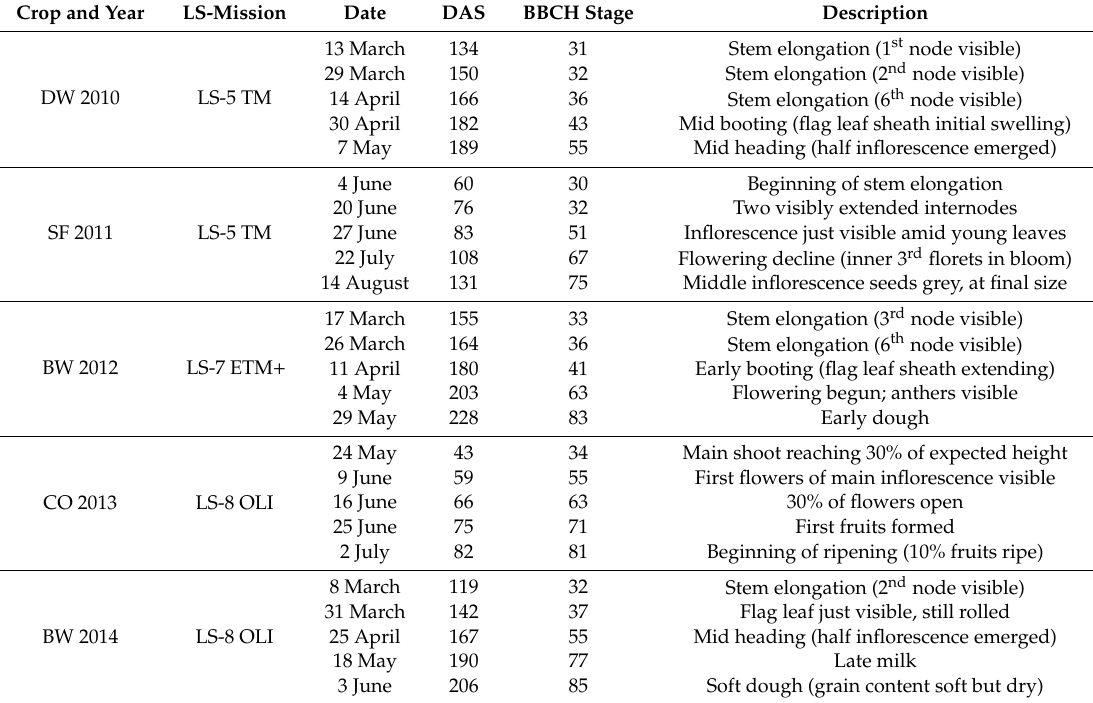
Table 2. Acquisition dates of Landsat satellite images and corresponding days after sowing (DAS) and growth stages (BBCH scale) in the five years.